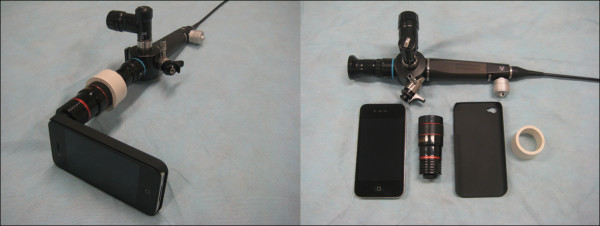
Fibreoptic bronchoscope with iPhone, lens, and rubber attachment.